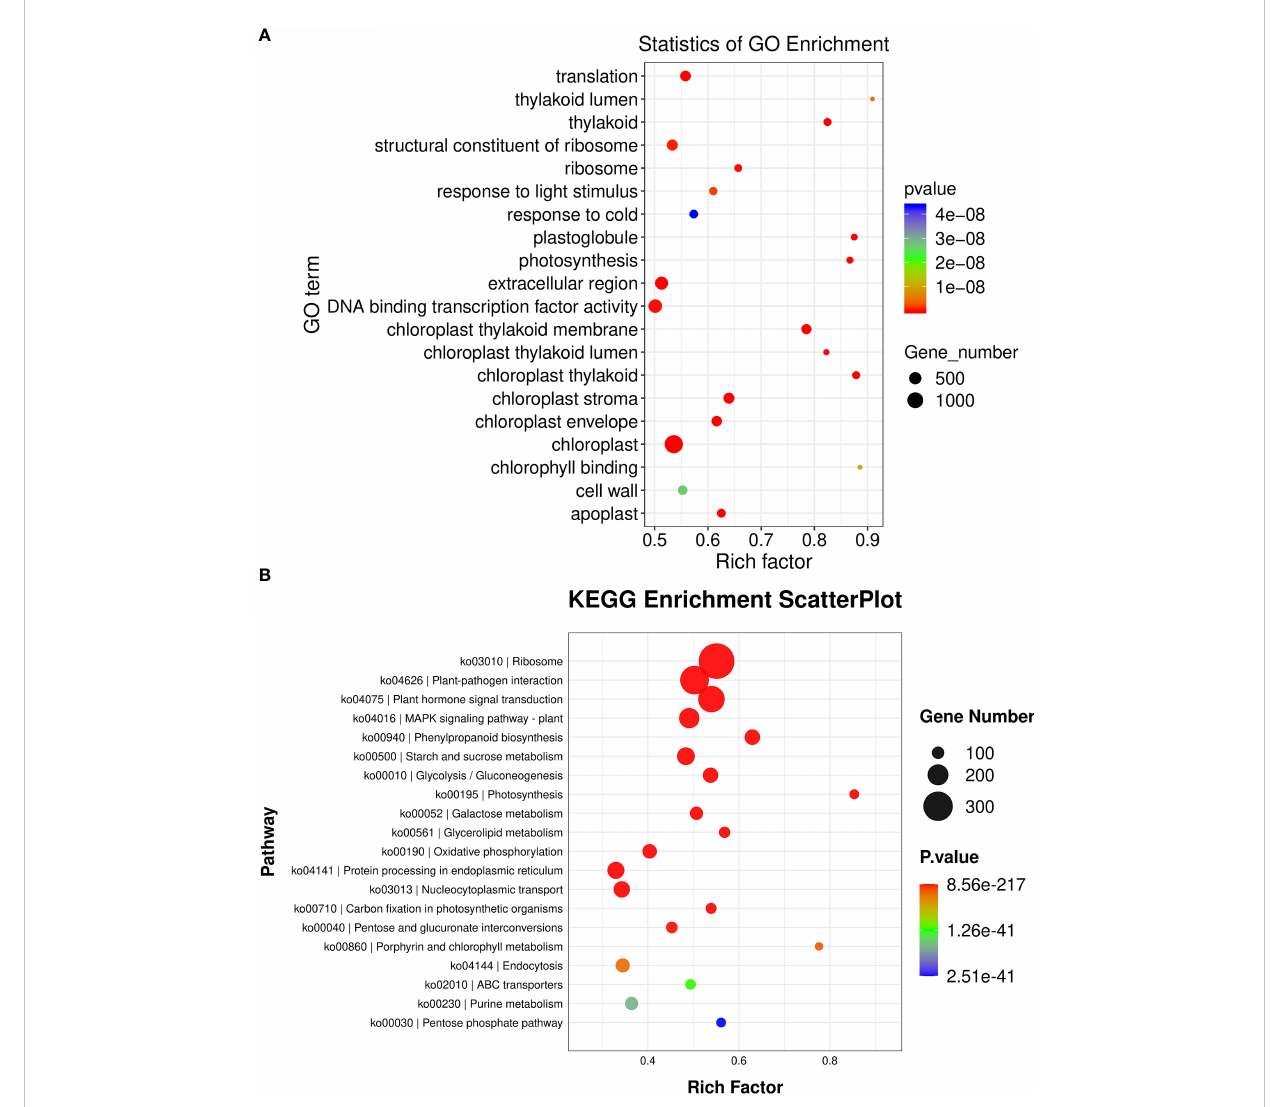
FIGURE 6 Functional annotations of differentially expressed genes. (A) : Enrichment analysis of air bubble diagram of GO gene differentially expressed in root and leaf of S. divaricata. (B) : Enrichment and analysis of bubble diagram of differentially expressed gene KEGG in root and leaf of S. divaricata.